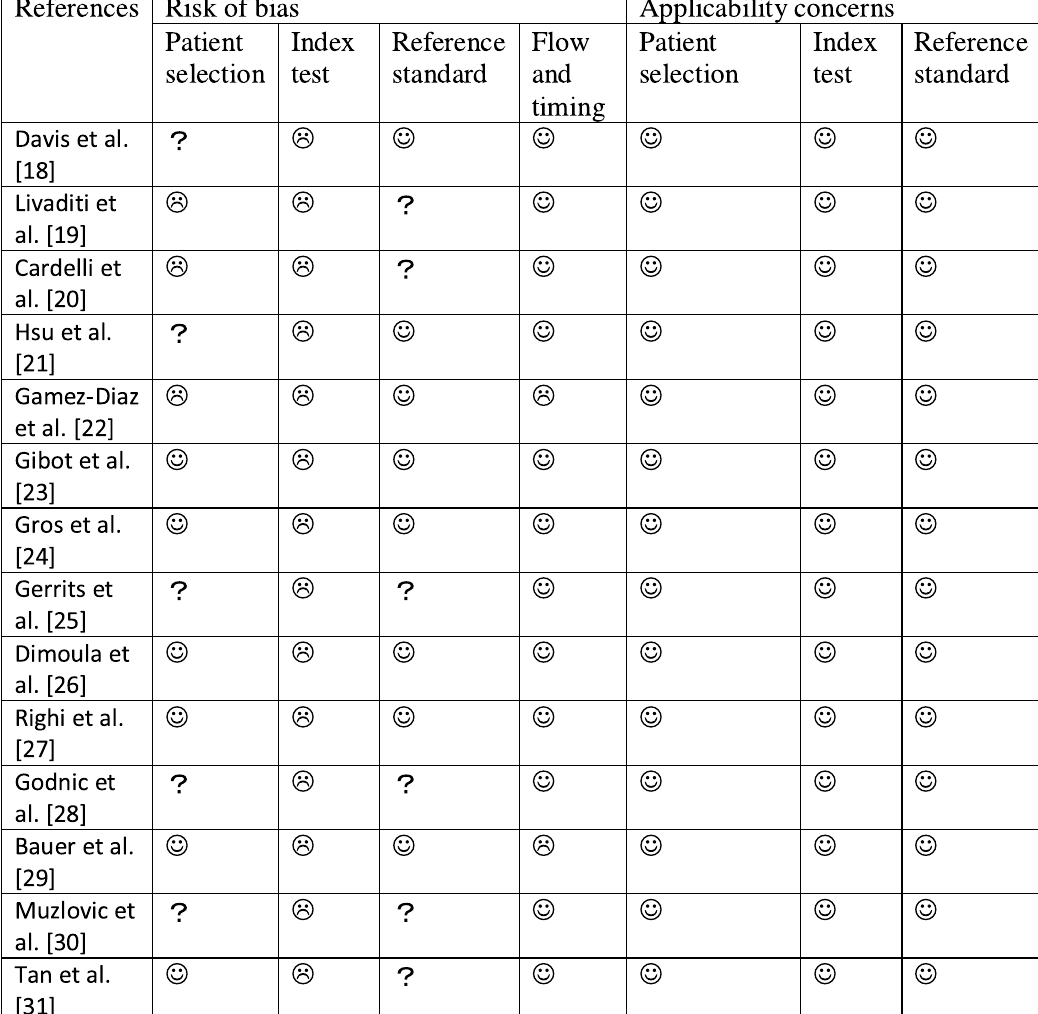
Table 2 Quality assessment for 14 studies